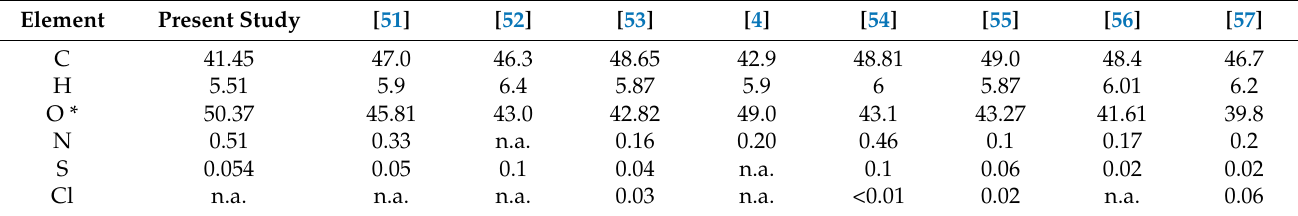
Table 3. Ultimate analysis of sugarcane bagasse sample compared with other studies (wt.%, dry basis).